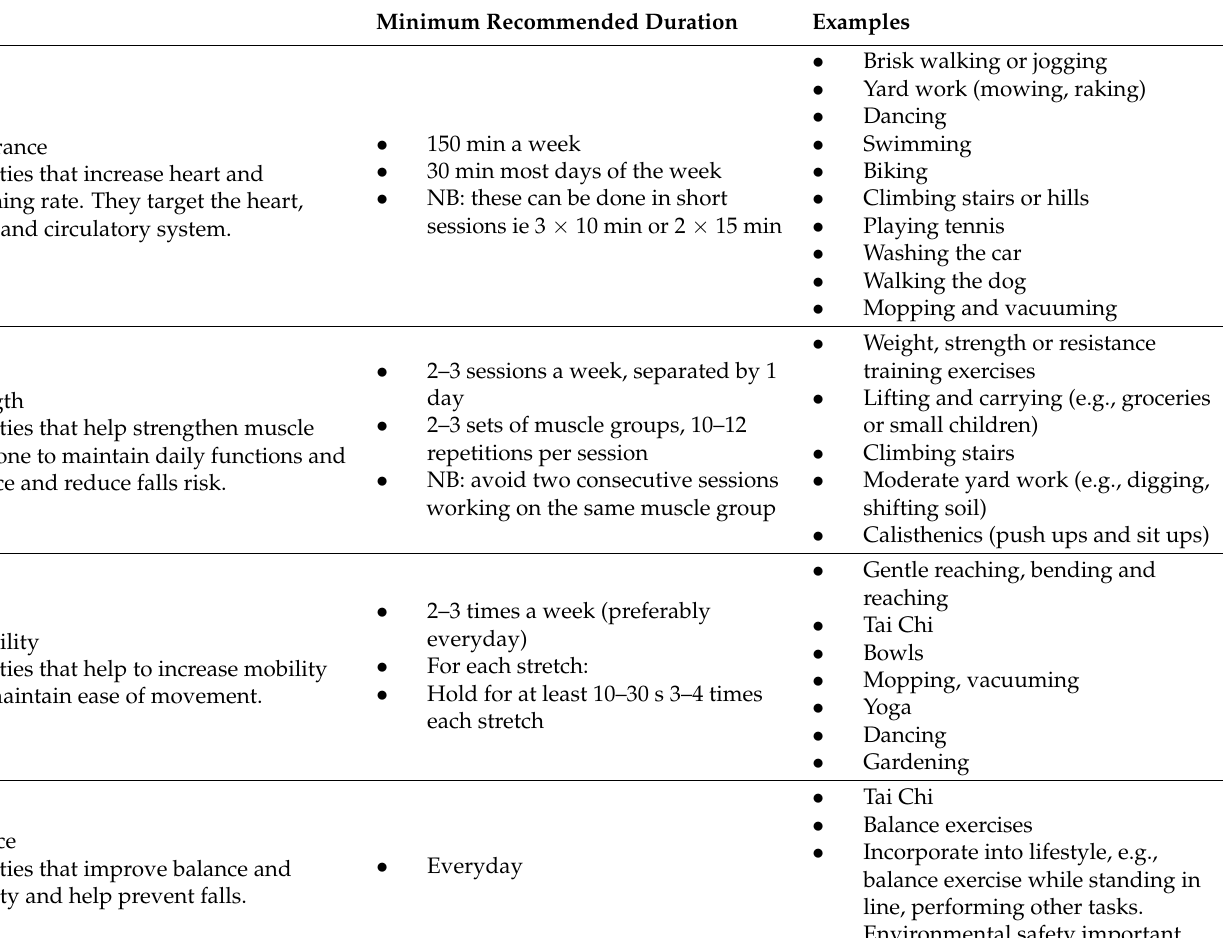
Table 1. Types of